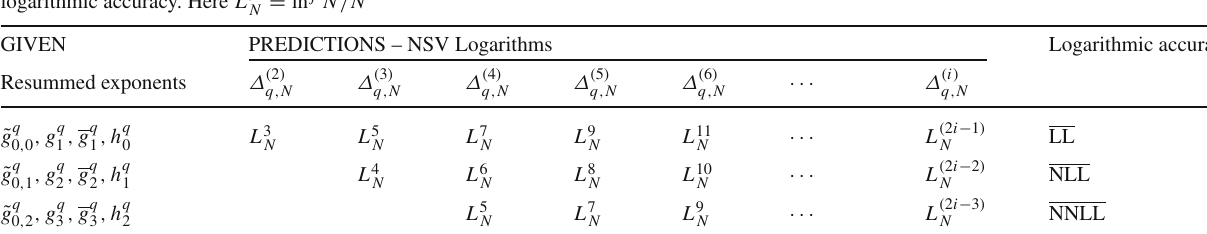
(cid:18) which is required to predict the tower of NSV logarithms in Δ q , N at a given